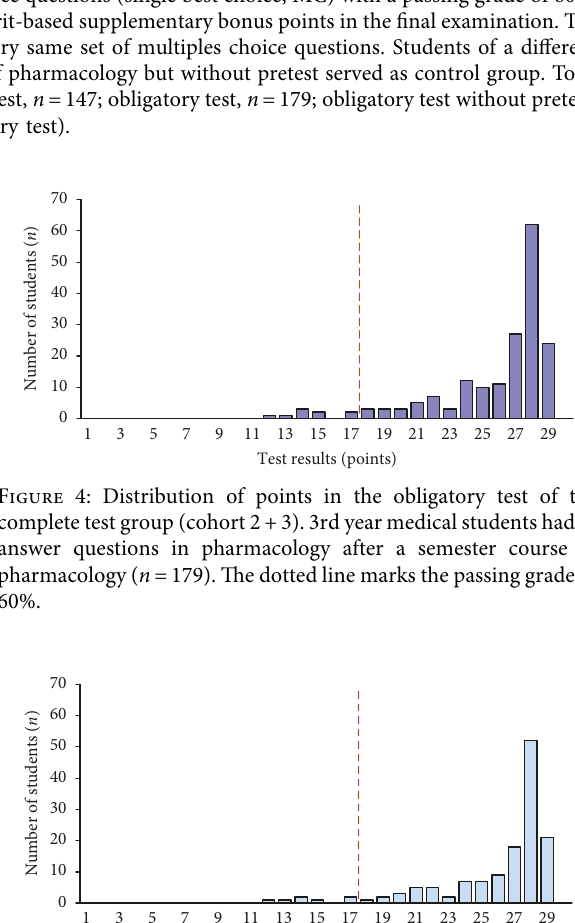
Figure 3: Distribution of points in the voluntary test of the test group (cohort 2). 3rd year medical students had to answer ques- tions in pharmacology before a semester course of pharmacology ( n � 147). The dotted line marks the passing grade of 60%.